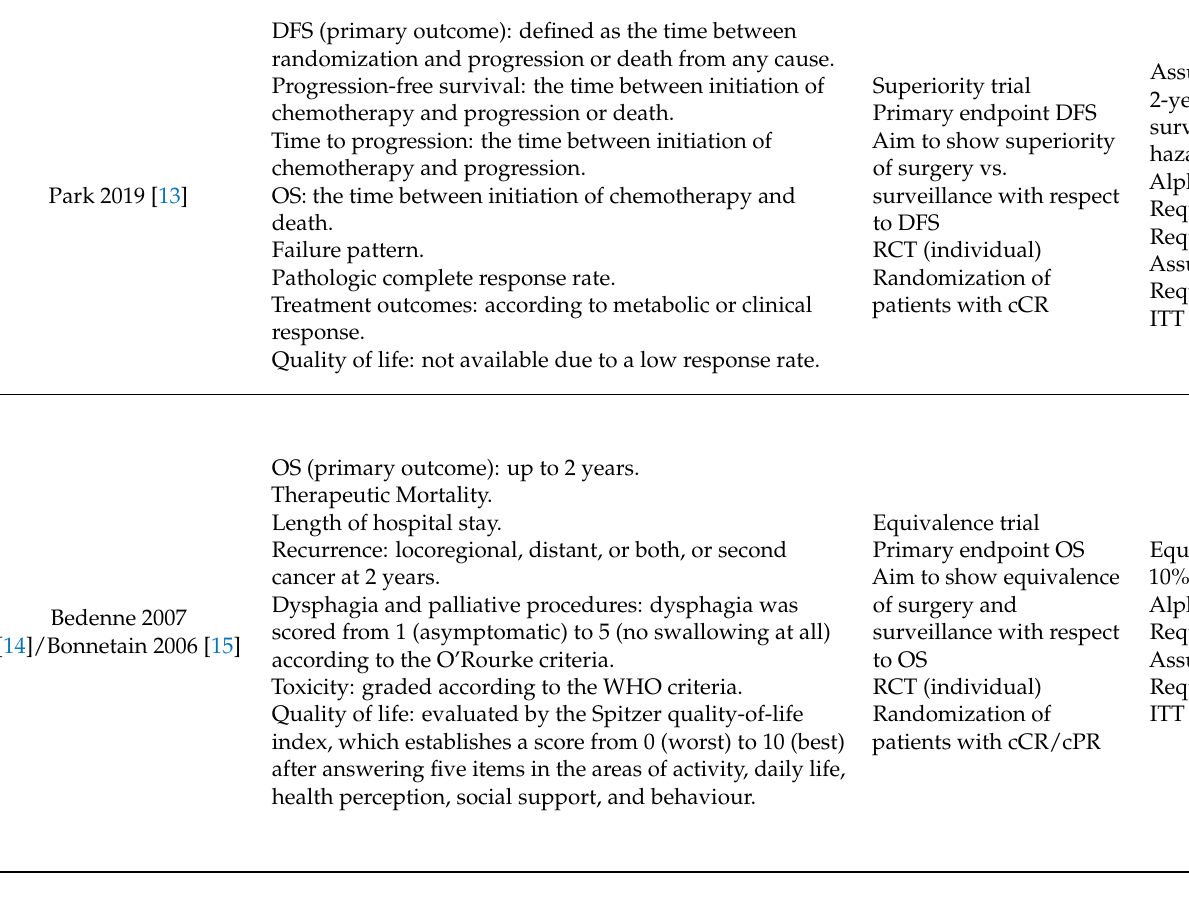
Table 4. Outcomes considered and design aspects in the randomized and non-randomized trials including protocols.